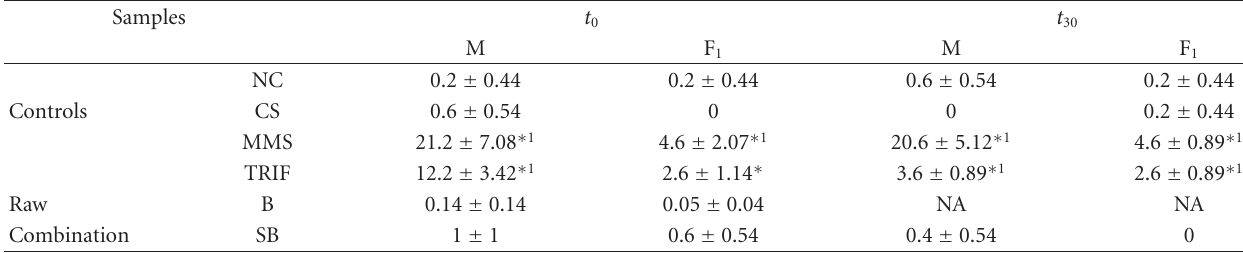
Table 4: Mean and standard deviation for micronuclei in cells of the meristematic region (M) and F 1 of Allium cepa after exposure to control soil, negative and positive controls, and biosolid